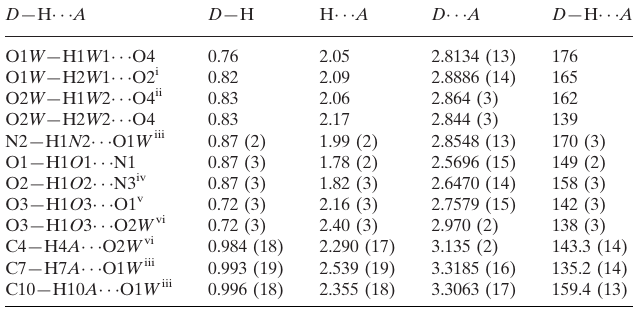
Hydrogen-bond geometry (A˚ , (cid:3) ). D —H (cid:2)(cid:2)(cid:2)